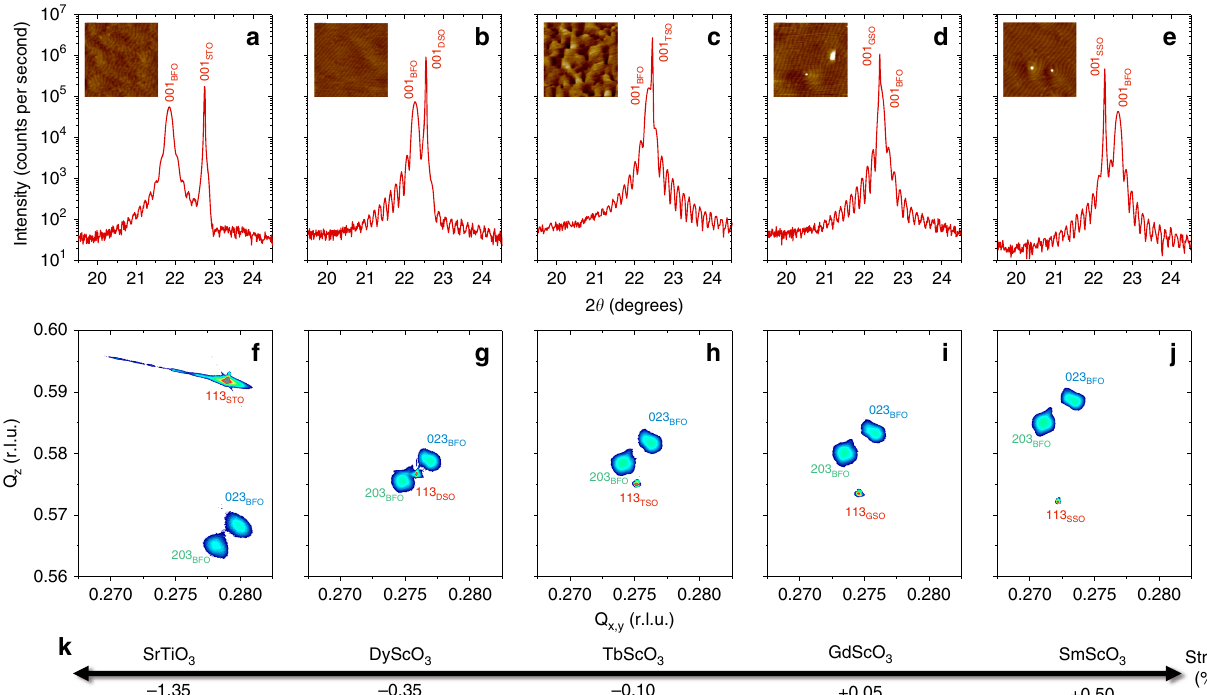
Fig. 1 Strain-engineered epitaxial BiFeO 3 thin fi lms. a – e , 2 θ – ω X-ray diffraction scans of BiFeO 3 (BFO) fi lms grown on SrTiO 3 (STO) ( a ), DyScO 3 (DSO) ( b ), TbScO 3 (TSO) ( c ), GdScO 3 (GSO) ( d ) and SmScO 3 (SSO) ( e ) substrates. The insets are 3 × 3 μ m 2 topography images acquired by atomic-force microscopy on the same fi lms, showing atomic steps and terraces. The z-scale is 4 nm. f – j Corresponding reciprocal space maps along the different (113) substrate peaks, showing in each case two elastic domains for BiFeO 3 , i.e. (203) and (023). The r. l. u. units of the in-plane and out-of-plane wavevectors, Q x,y and Q z , respectively, stand for reciprocal lattice units. k Sketch of the evolution of the calculated epitaxial strain in BiFeO 3 as a function of the substrate. The scandate and BiFeO 3 crystallographic peaks are de fi ned in a monoclinic cell.